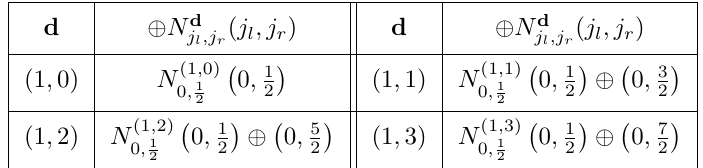
Table 2. The result of solving the SU(2) 0 blowup equation at d 1 = 1 order for the background flux B m = 0 .